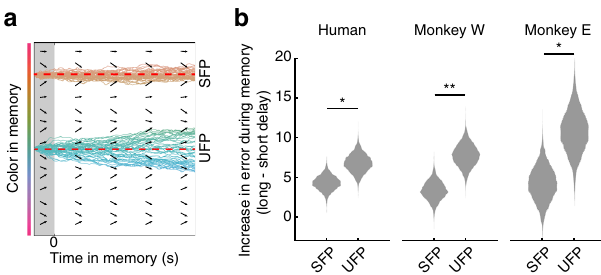
Fig. 5 Memories near attractors are more stable. a If discrete attractors underlie working memory, then memories of different target colors will accumulate error at different rates over time. Memories of target colors near stable fi xed points (SFPs) accumulate a relatively small amount of error over time because perturbations away from SFPs due to random noise are corrected by drift back towards the SFP. Unstable fi xed points (UFPs) lie in between attractors; perturbations away from UFPs due to random noise are exacerbated by drift away from the UFP. Red dashed lines the indicate location of two of the fi xed points. b Mean increase in error at SFPs and UFPs identi fi ed by the fi t model. Distributions re fl ect